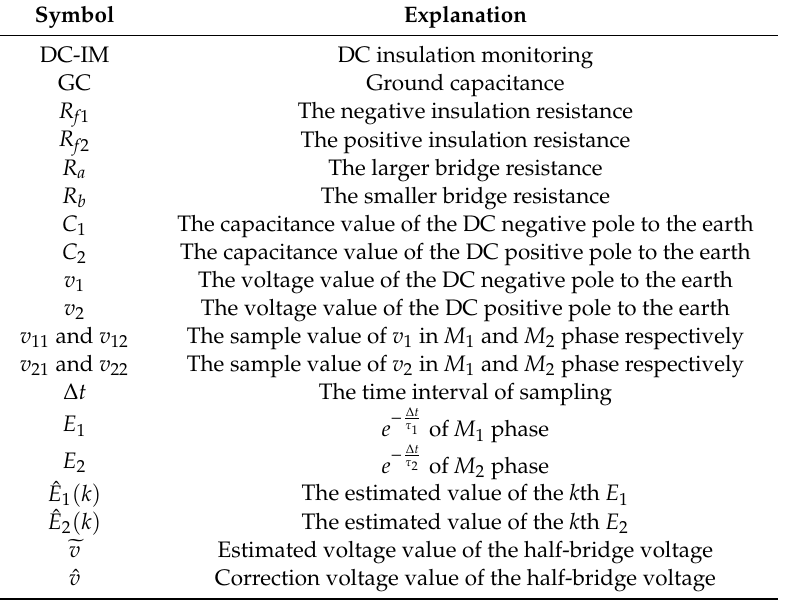
Table 1. List of some symbols used in the operation